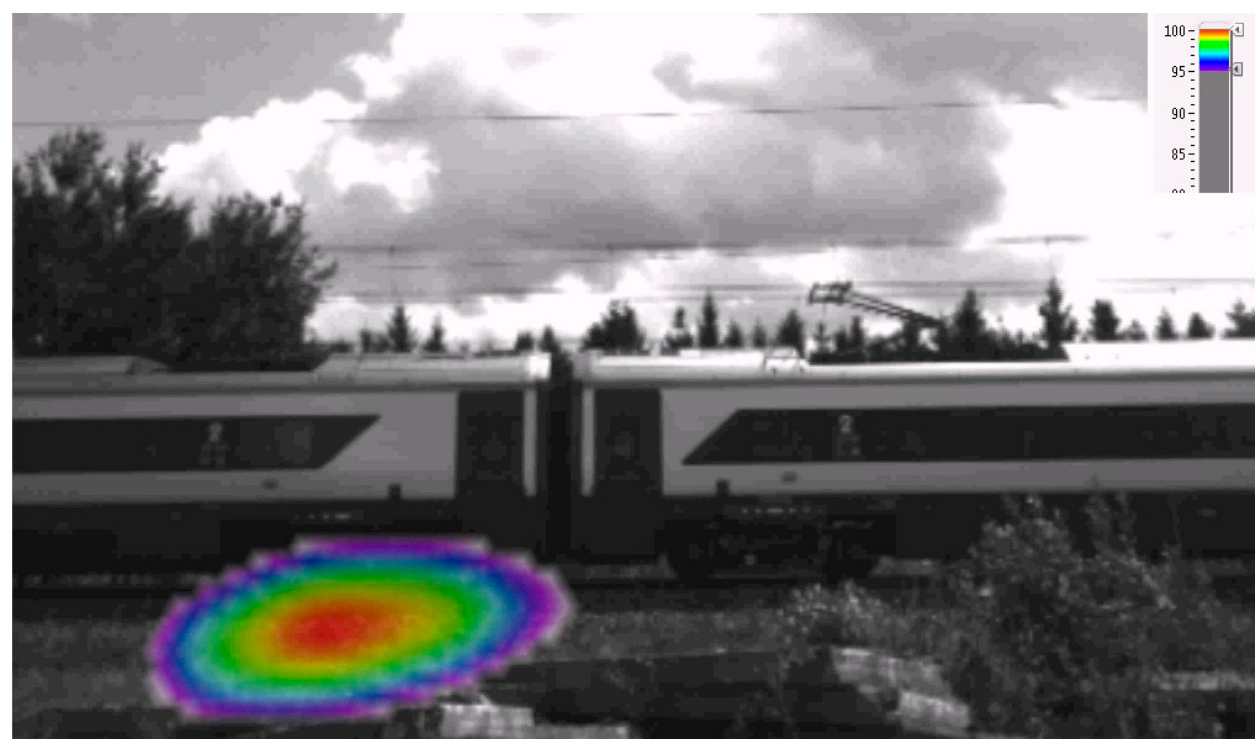
Figure 10. Sound level distribution within a frequency range of 500–1000 Hz—straight section .